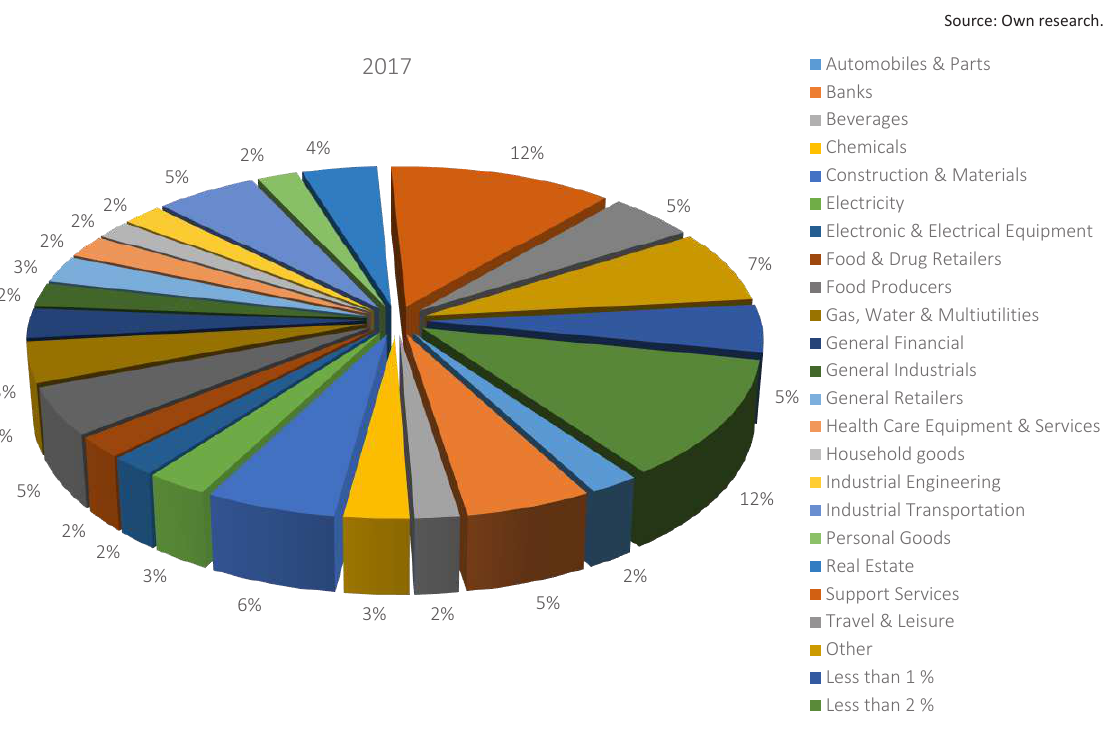
Figure 1. The percentage share of individual industries in the total number of integrated reports in the EU in 2013